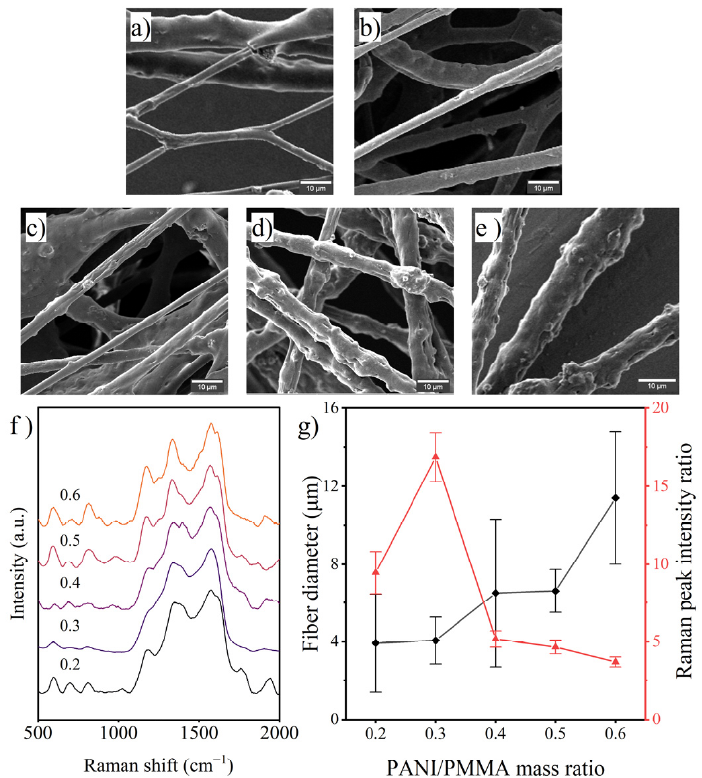
Figure 3. SEM images of fibers prepared with various PANI/PMMA mass ratios: ( a ) 0.2, ( b ) 0.3, ( c ) 0.4, ( d ) 0.5, ( e ) 0.6; ( f ) Raman spectra of the fibers and ( g ) effects of the PANI/PMMA mass ratio on fiber diameter and surface PANI occupancy.